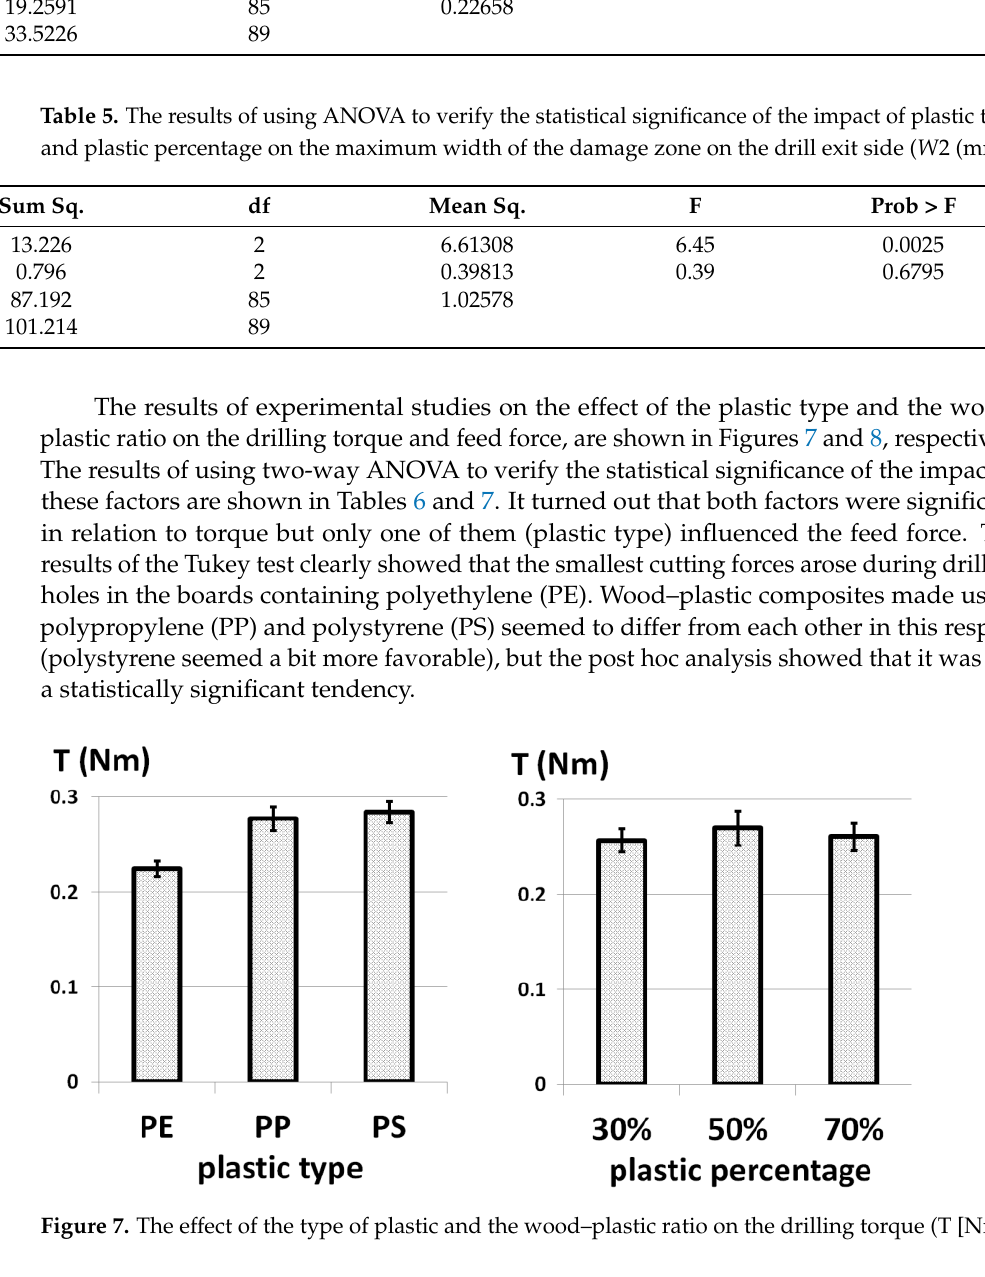
Figure 8. The effect of the type of plastic and the wood – plastic ratio on the feed force (F [N]). Table 6. The results of using ANOVA to verify the statistical significance of the impact of plastic type and plastic percentage on the on the drilling torque (T (Nm)).